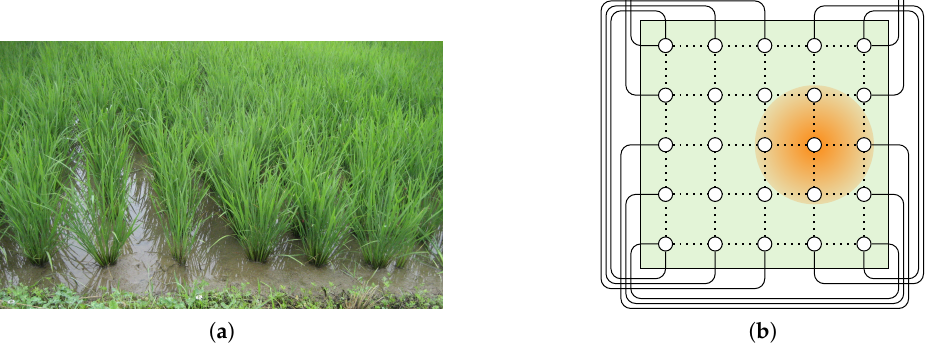
Figure 1. ( a ) A paddy field with young crops. ( b ) A sensor network for a paddy field where the small circles represent sensors. The orange disc represents the transmission range of the sensor at its